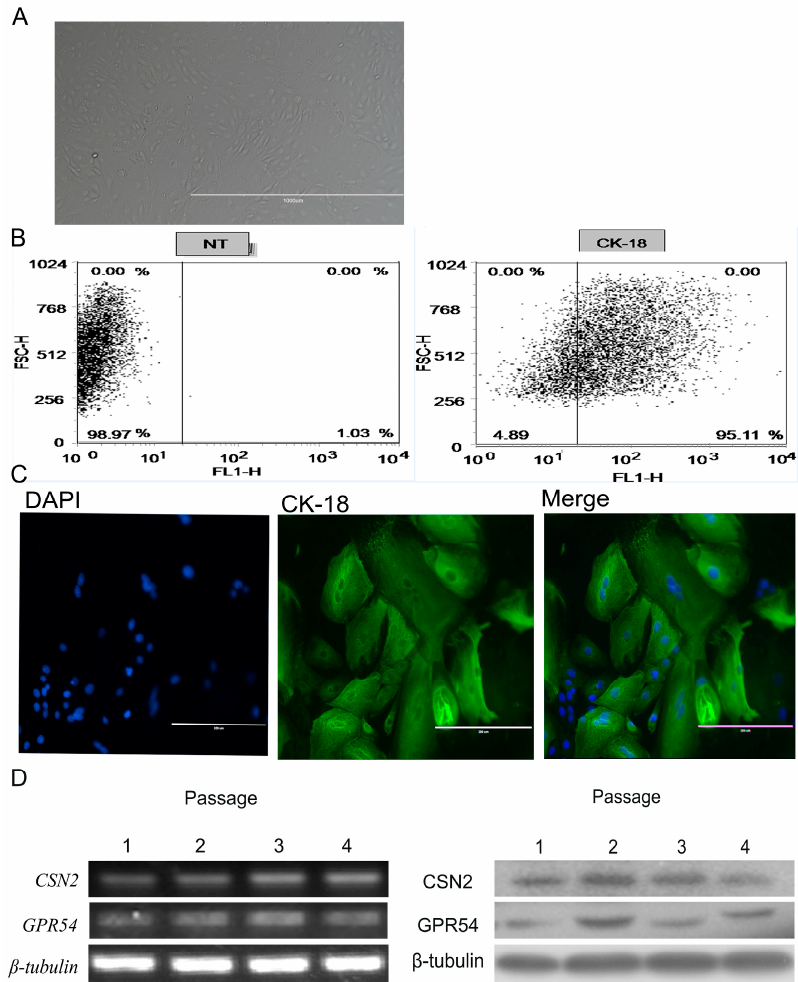
Figure 2. Bovine mammary epithelial cells (bMECs) culture and identification. ( A ) Morphology of cultured bMECs. Cells show the typical islands morphology of epithelial cells (bar = 200 µ m); ( B ) The expression of CK-18 was detected by flow cytometry in bMECs; ( C ) Immunofluorescence labeling of CK-18 in bMECs (200 × magnification) (bar = 200 µ m); ( D ) Gene and protein expression of CSN2 and GPR54 in cultured bMECs (passages 1–4) ( n = 3).